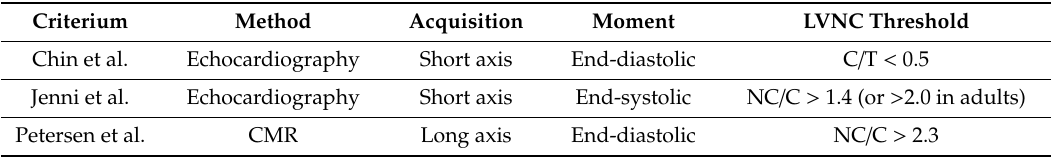
Table 2. Criteria for detection of LVNC in the clinical practice.